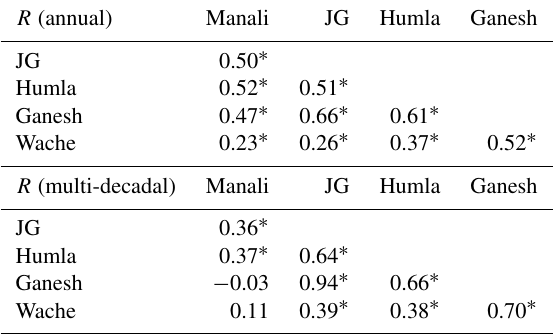
Table 2. Correlation coefficients between the tree-ring δ 18 O records from different sampling